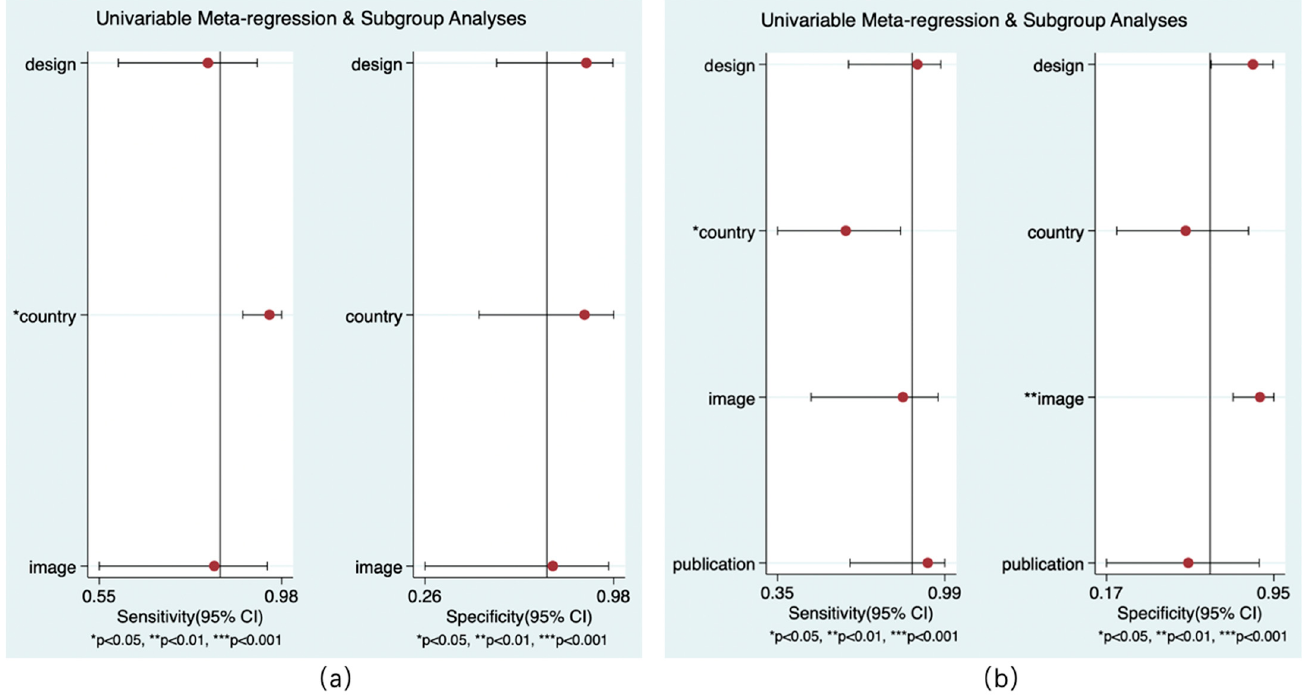
Figure 9. Results of meta ‐ regression. rCBF ( a ) and rCBV ( b ) .